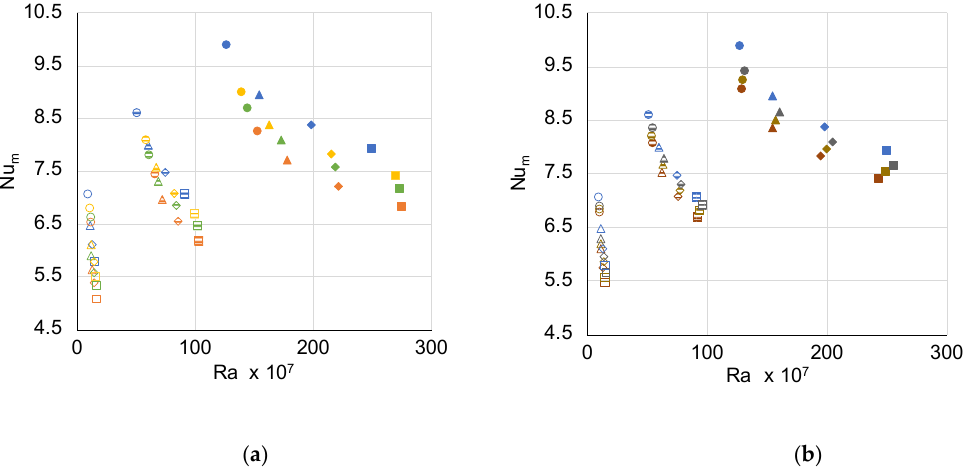
Figure 9. Change of Nu m with Ra for ( a ) MTP and ( b ) PTP.